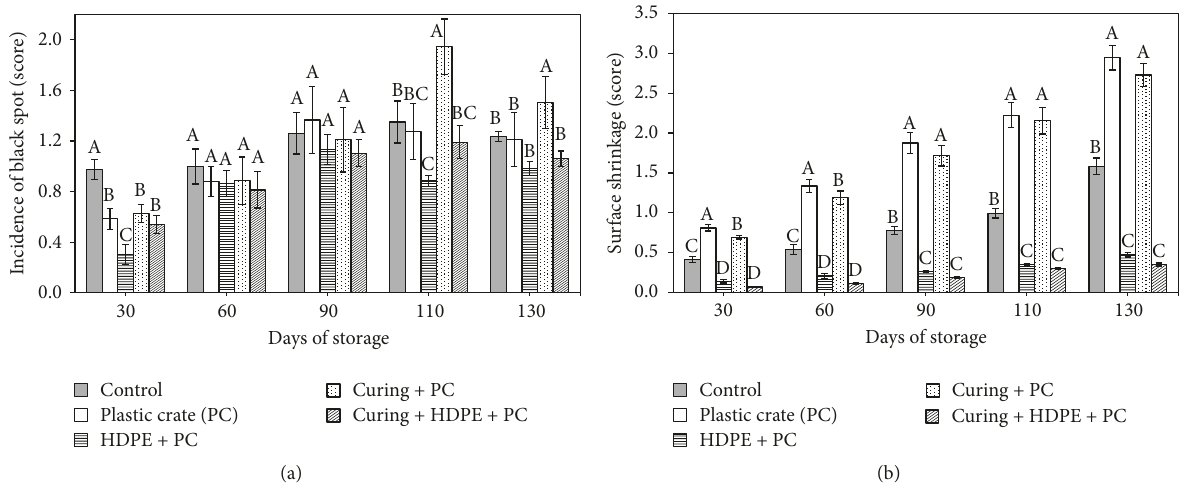
Figure 5: Black spot incidence score (a) and surface shrinkage score (b) of radish roots during storage at low temperature under different packaging treatments. Vertical bars represent ± SE of mean. For each evaluation day, different letters indicate significant differences ( 𝑃 < 0.05 ) among